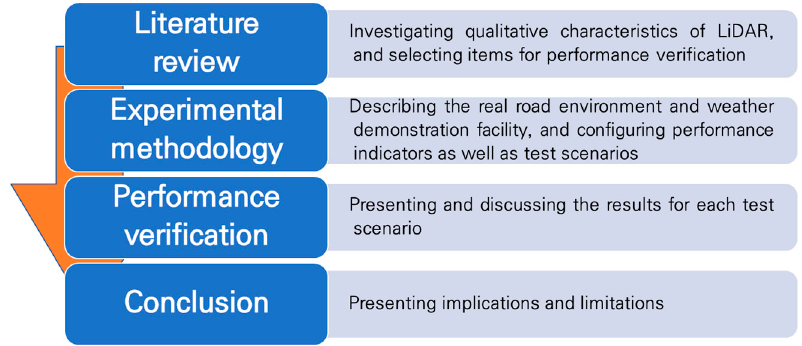
Figure 1. Structure of the